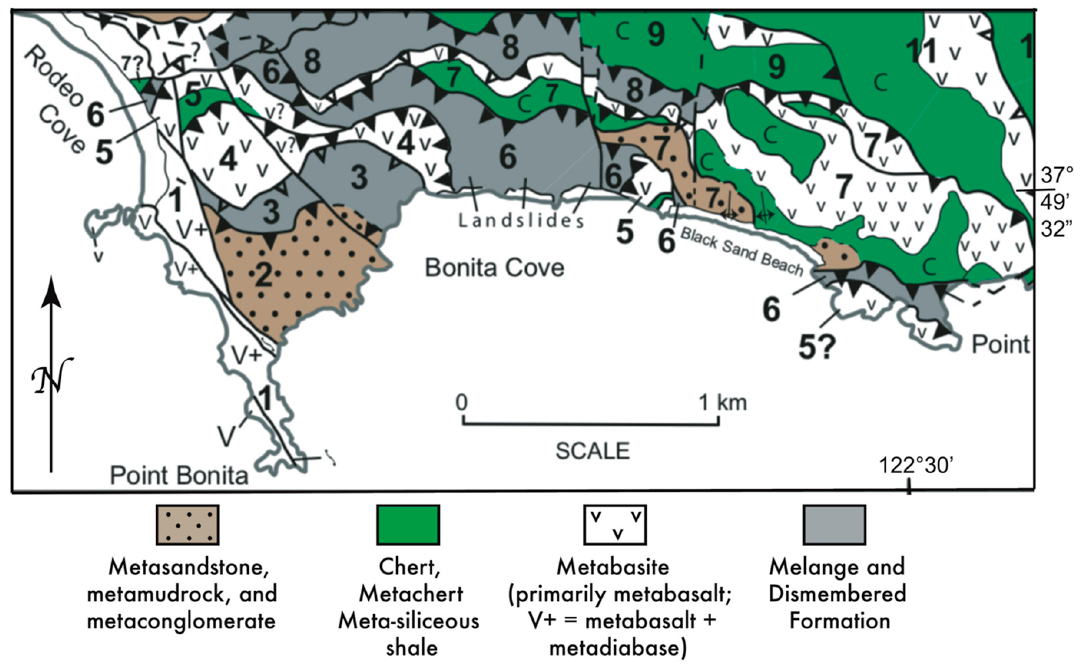
Figure 5. Geologic map of the southwestern, OPS-dominated, Marin Headlands block of the Franciscan Complex (after [46,47] and based on [23,50,51,84] and mapping by the author). Unit six is the Rodeo Cove Mélange.